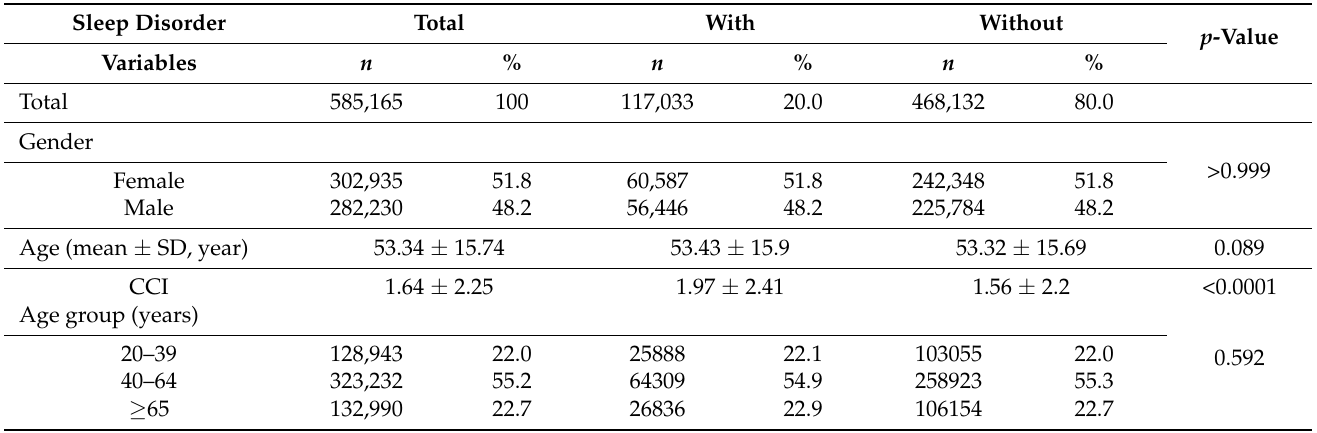
Table 1. Characteristics of study